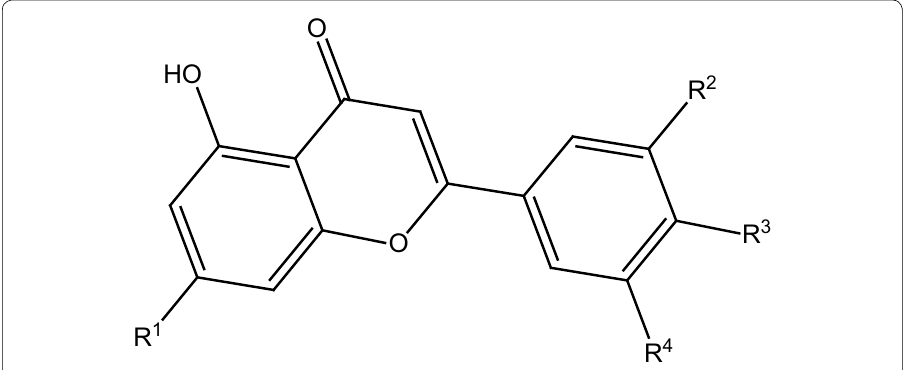
Fig. 1 Bridelia ferruginea B. dye (where R 1–4